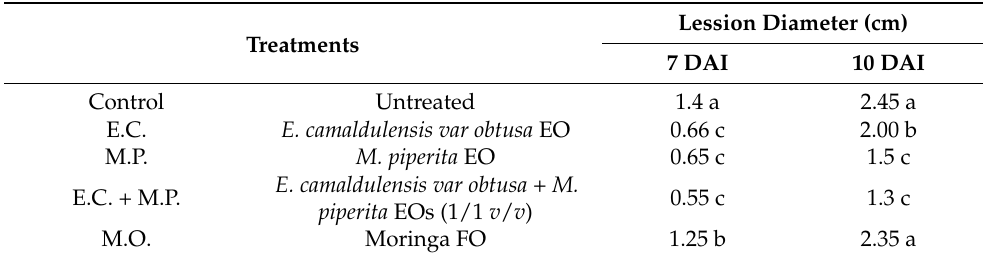
Table 8. Rot caused by Botrytis cinerea . Lesion diameter (cm) on strawberry fruits after treatment with different oils.